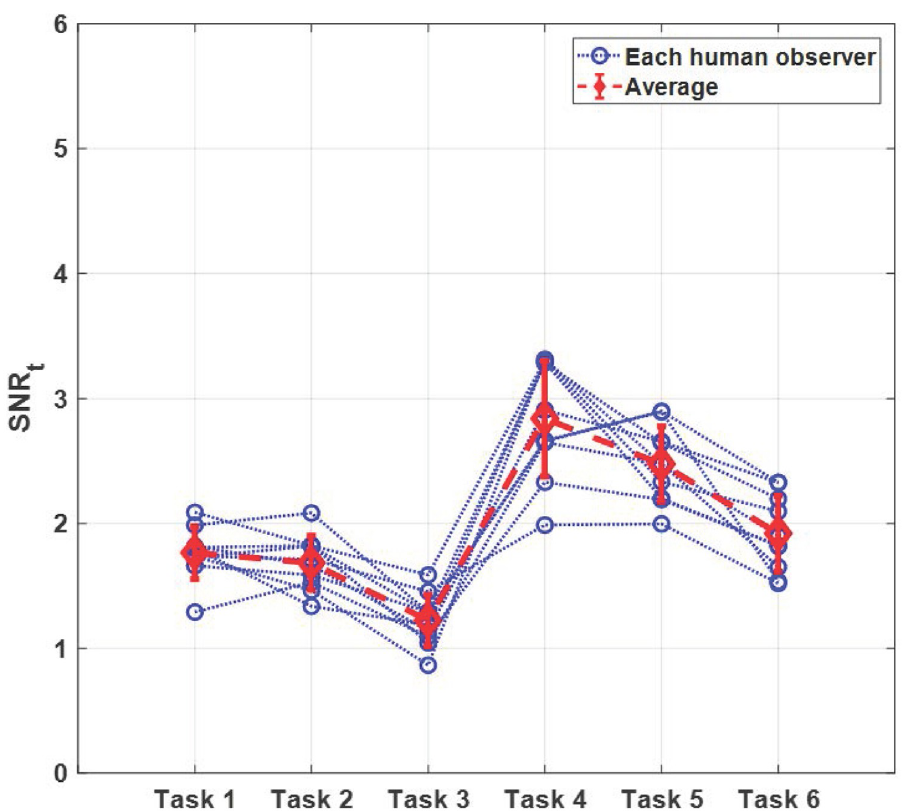
Fig 5. SNR t values of human observer study. The SNR t values of each human observer (indicated by the blue dotted line and circle marker) and averaged SNR t value (indicated by the red dashed line and diamond marker) with 95% confidence intervals for all